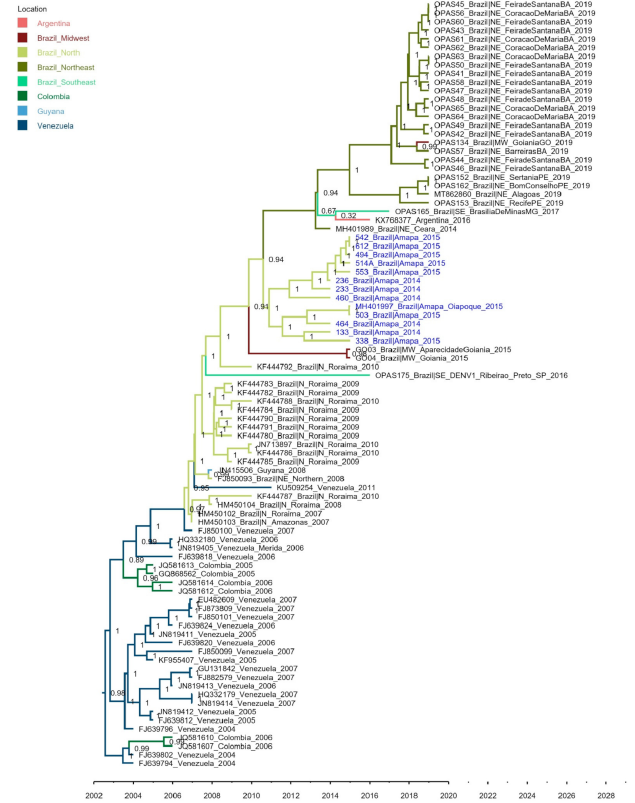
Figure 2. Time-scaled Bayesian phylogeny tree of the BR4 lineage of DENV-1. The tree was inferred using 88 sequences of DENV-1. The time-scale is shown. Amap á sequences are highlighted in blue. This tree was inferred using 88 sequences of DENV-1 genotype V. The branch colors refer to geographic location of collection of virus samples as well as inferred ancestral strains. Nodes numbers refer to its geographic probability. The maximum clade credibility (MCC) tree was inferred using Beast software. Table 1. Codons under evidence for adaptive selection on the complete genome of DENV-1 lineage BR4. Codon